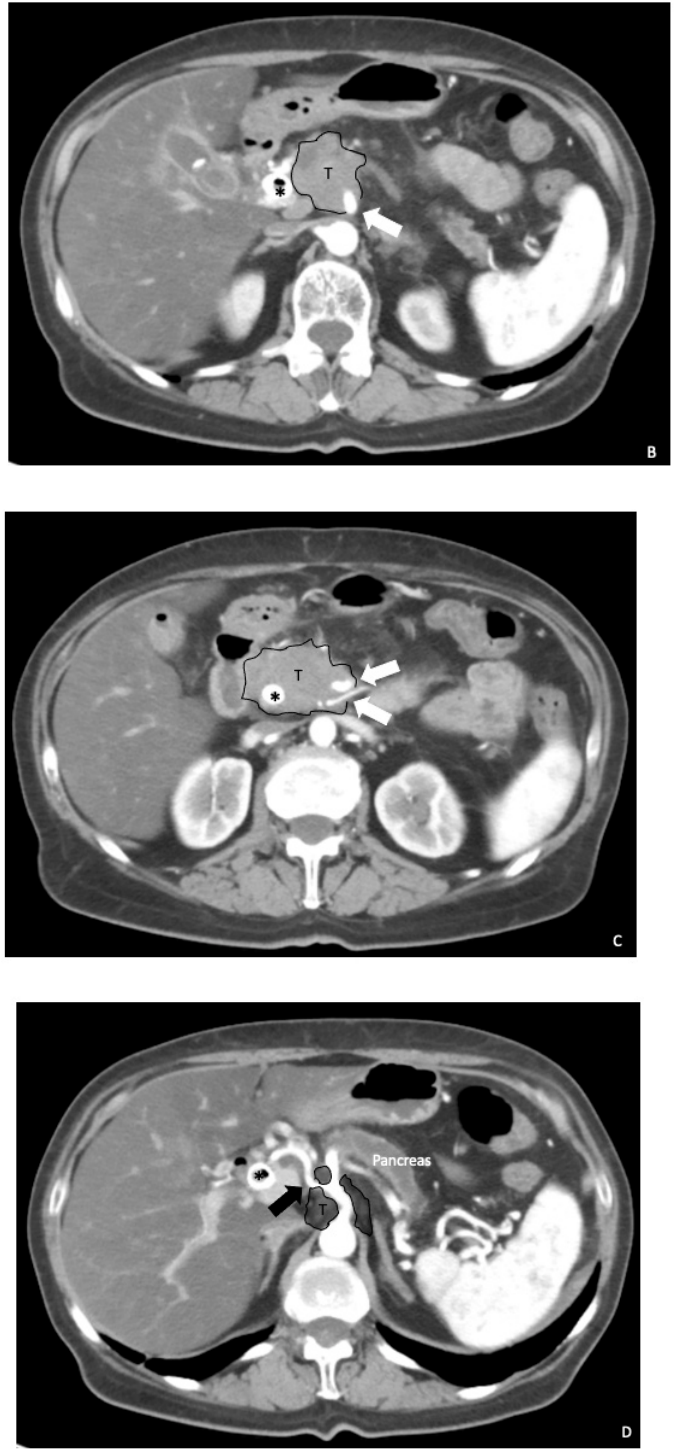
Figure 1. A 67 year old female patient with jaundice and abdominal pain. Endoscopic ultrasound biopsy confirmed poorly differentiated PDAC and a biliary stent was placed (asterisk). MDCT shows expansive pancreatic formation located in the cephalic portion, with poorly defined limits, measuring approximately 54 × 32 mm ( A ). Exophytic tumor (T), encompassing the SMA and distal branches (white arrow) and the spleno–mesenteric–portal confluence, extending towards the superior mesenteric vein (encasement) ( B , C ). Cephalically it extends towards the celiac trunk, encompassing its terminal branches (black arrow) ( D ).